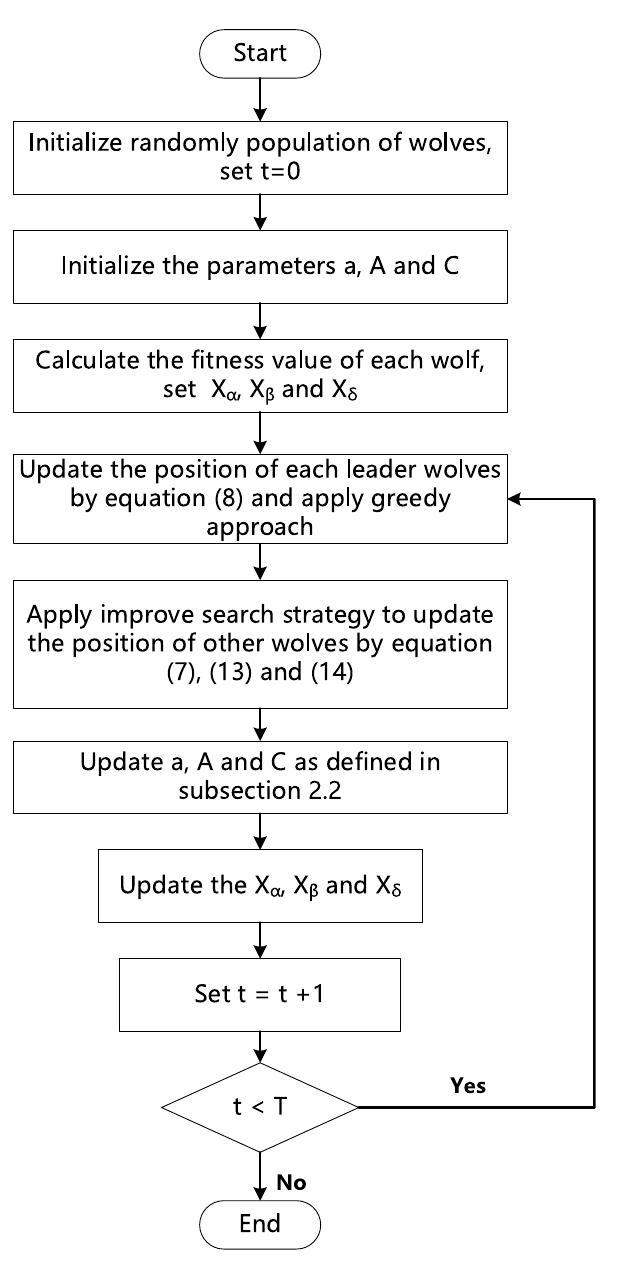
Figure 4. The flow chart of CG-GWO algorithm.